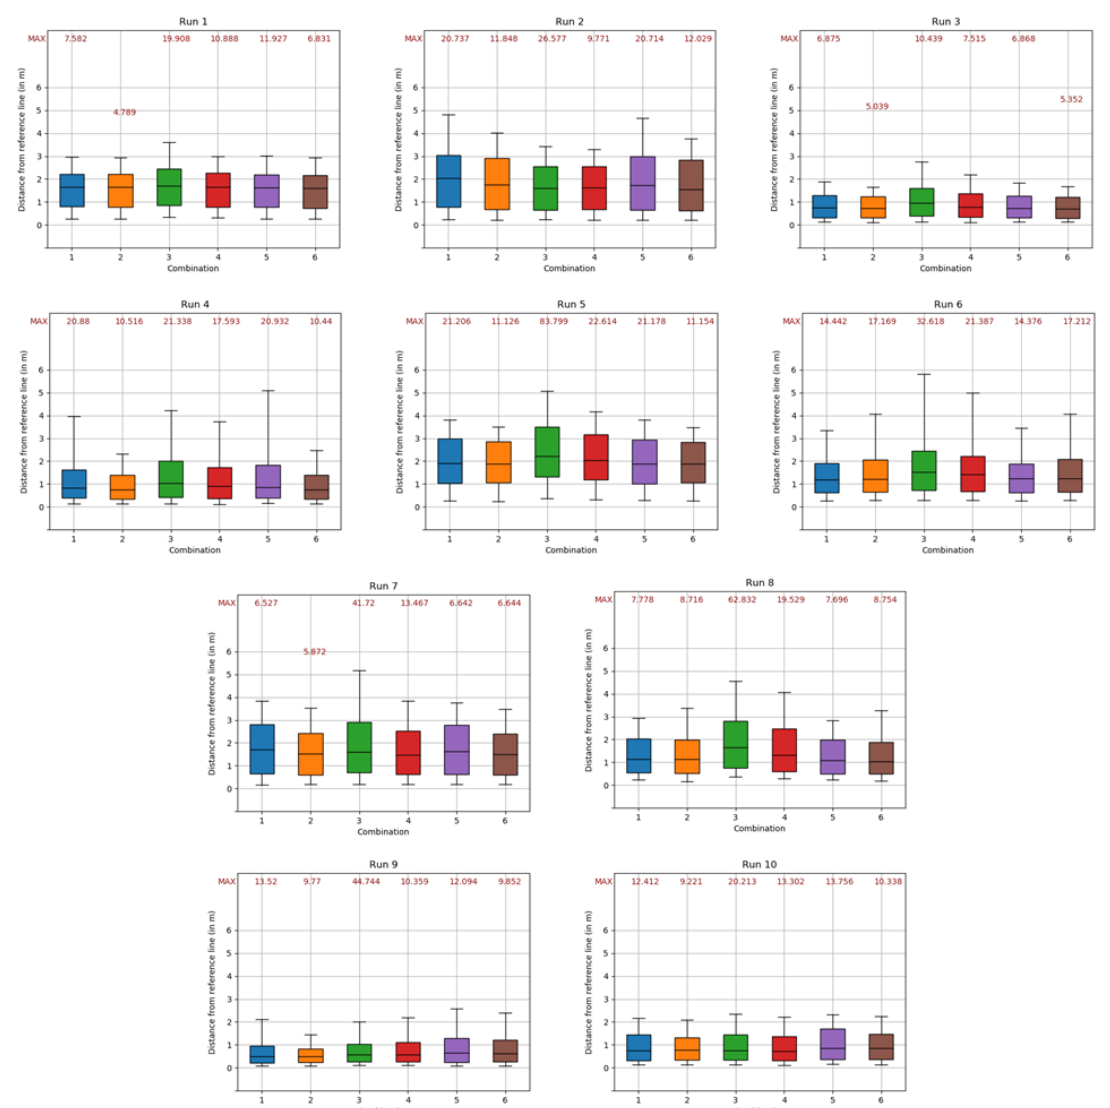
Figure A4. Boxplots of perpendicular distances of points for all combinations and all